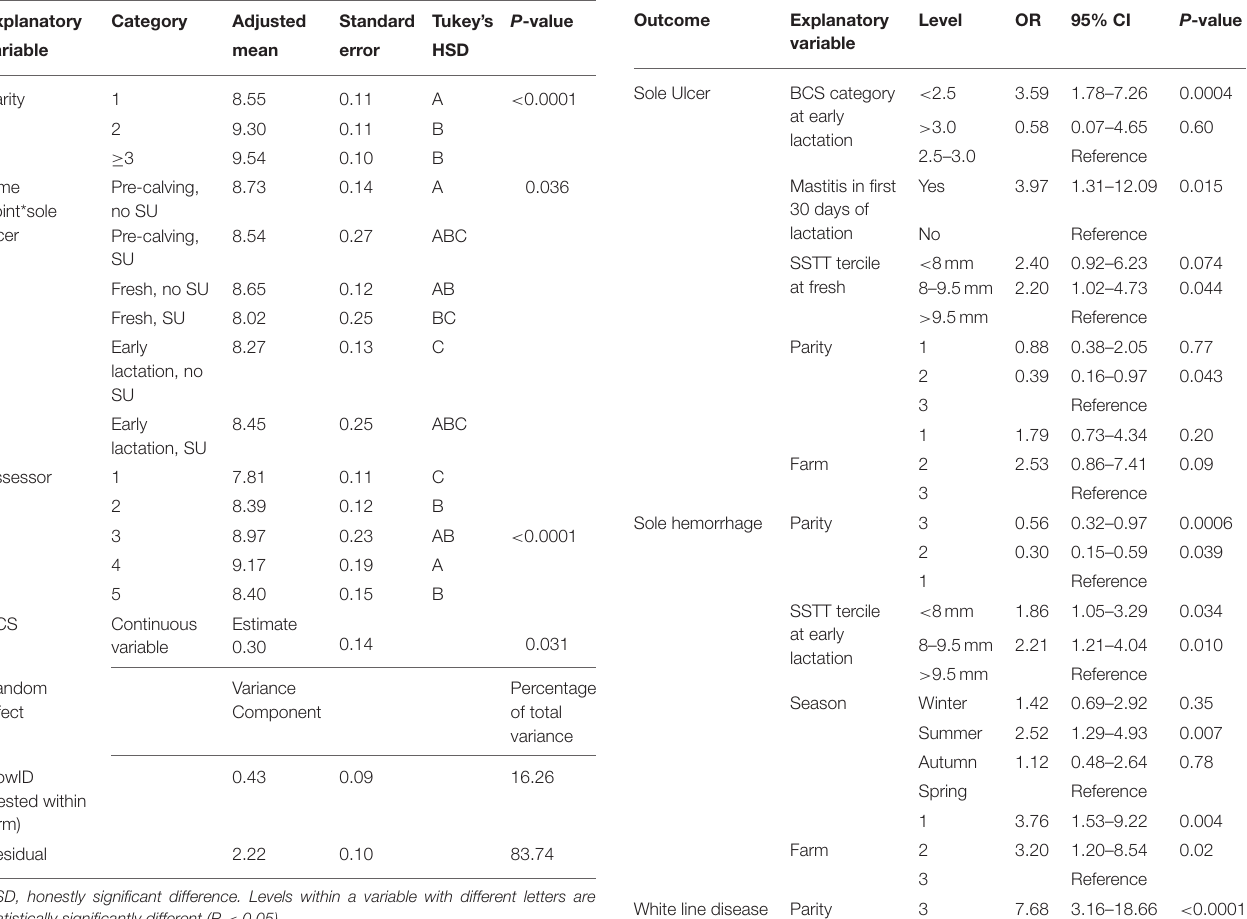
TABLE 2 | Results from multivariable mixed effects linear regression model for outcome sole soft tissue thickness (SSTT) (mm). Explanatory